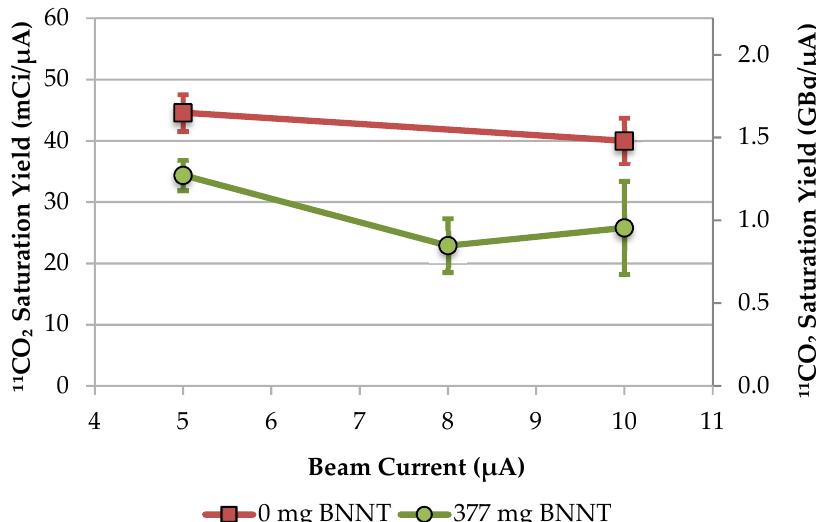
Figure 15. 11 CO 2 saturation yield for the BN-124 target using a fill gas of nitrogen with 1% oxygen.